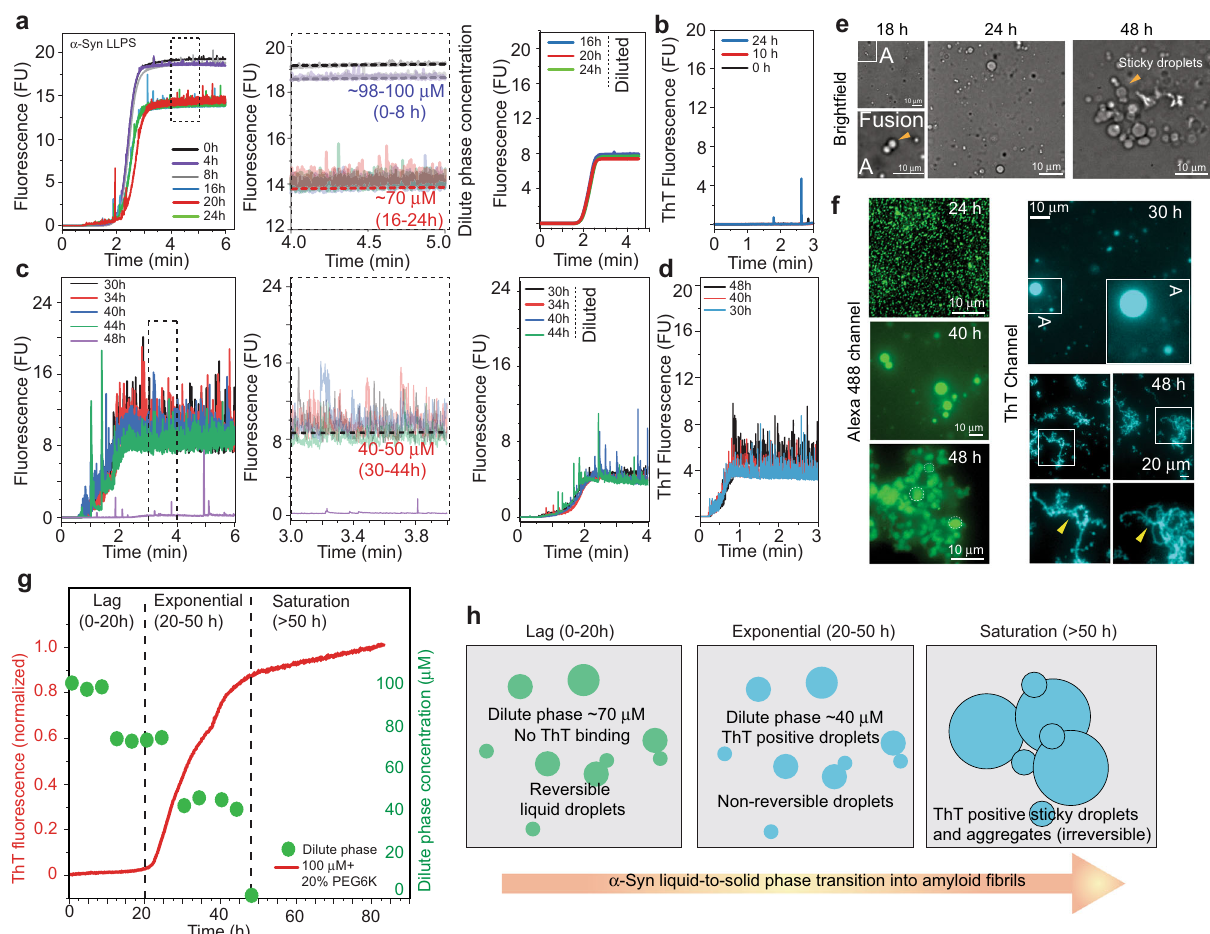
Fig. 6 Simultaneous monitoring of α -Syn LLPS and subsequent amyloid aggregation using Cap fl ex. a (Left panel) Cap fl ex measurements of α -Syn LLPS samples spiked with 10 nM Alexa488 labeled α -Syn until 24 h is shown. The appearance of peaks with time indicates LLPS of α -Syn. (Middle panel) A magni fi ed view of the fl uorescence readouts from Cap fl ex showing the evolution of dilute phase concentration during α -Syn LLPS. (Right panel) Until 24 h, the reversibility/dissolution of α -Syn LLPS upon dilution with buffer is con fi rmed by the disappearance of signal spikes in Cap fl ex. The data is obtained from the same samples as the one in the left and middle panel. b Cap fl ex readouts in ThT channel for 0, 10, and 24 h samples. c (Left panel) Cap fl ex measurements of α -Syn LLPS samples (Alexa488 channel) from 30 to 48 h. (Middle panel) A magni fi ed view of the fl uorescence readouts from Cap fl ex showing the dilute phase concentrations during 30 – 48 h incubation. (Right panel) The signal spikes do not disappear upon dilution with buffer indicating the irreversible nature of the system after 30 h. d ThT signal spikes are observed for the samples after 30 h suggesting the presence of amyloid aggregates. Representative Cap fl ex traces are reported. n = 2 independent experiments ( a – d ). e Bright fi eld microscopy images of liquid droplets after 18 h. A fusion event is magni fi ed and indicated with a yellow arrowhead. n = 2 independent experiments. f (Left panel) fl uorescence microscopy images of Alexa488 labeled α -Syn droplets at 24, 40, and 48 h. (Right panel) fl uorescence microscopy images of α -Syn droplets spiked with 10 µ M ThT at 30 and 48 h. Amyloid fi bril like morphology is observed only after 48 h. g Normalized ThT fl uorescence showing amyloid aggregation of 100 µ M α -Syn (in 10 mM PBS, 200 mM NaCl, pH 7.4) in the presence of 20% (w/v) PEG6000 (red) is overlaid with the dilute phase concentration obtained from Cap fl ex measurements (green). The lag, exponential and saturation phases are marked with black dashed lines. n = 2 independent experiments. h Schematic depicting the aberrant phase transition of α -Syn LLPS from a reversible state to a non-reversible state. Source data are provided as a Source Data fi